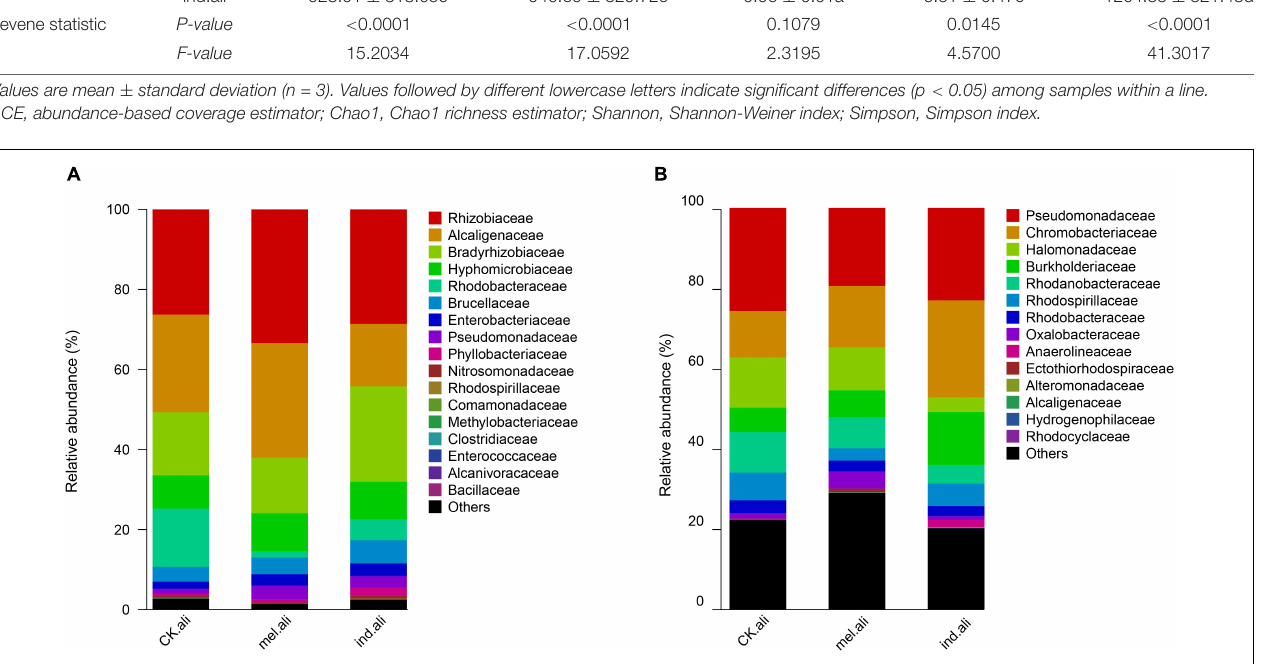
of rhizosphere soil, and the associated nirK - and nirS